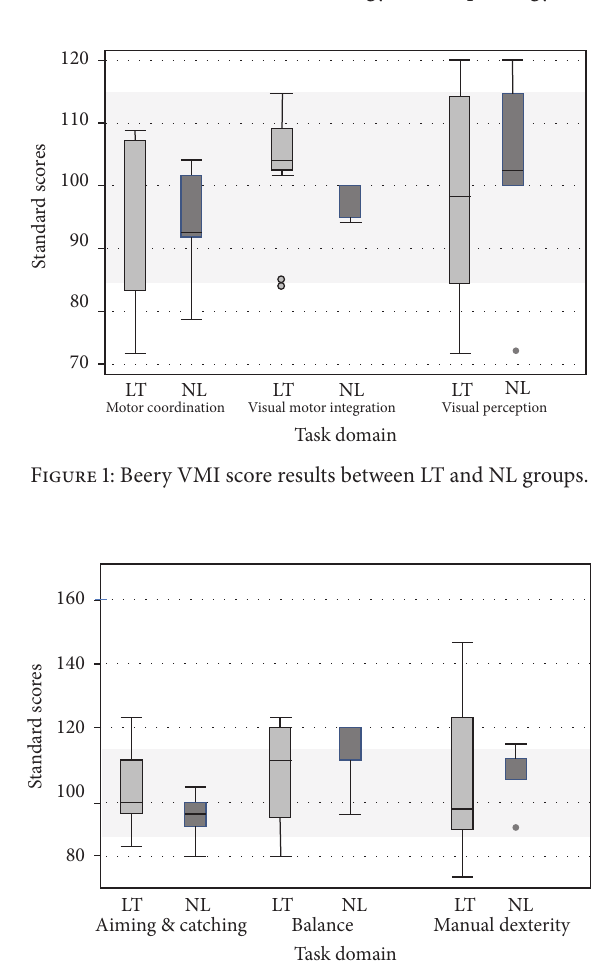
Figure 2: Movement ABC score results between LT and NL groups.